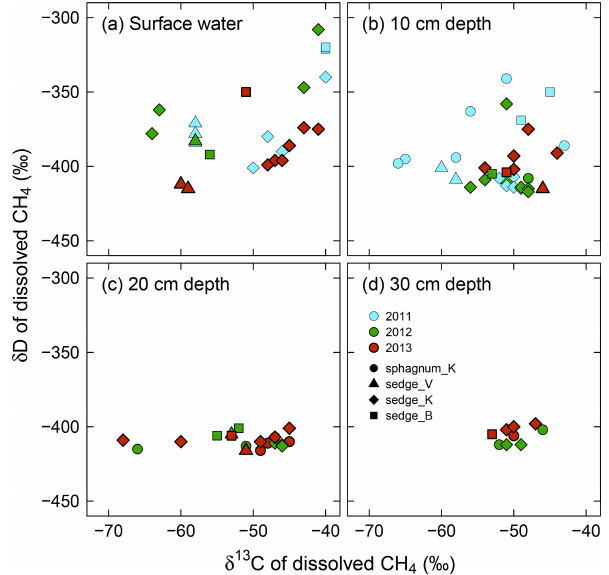
Figure 4. Interannual variation in dissolved CH 4 concentration in (a) surface water and soil pore water at (b) 10cm, (c) 20cm, and (d) 30cm in depth in wet areas from 2011 (wetting event) to 2013. Different letters in each panel denote statistical differences among years in averaged concentration across the four wet areas ( p < 0 . 05). Error bars represent standard deviations. See Table S3 for numerical values of dissolved CH 4 concentrations.